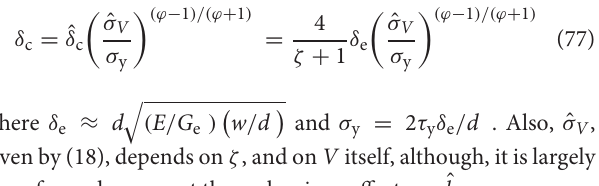
FIGURE 2 | Tows with fibers in a planar array and matrix parameters, ϕ